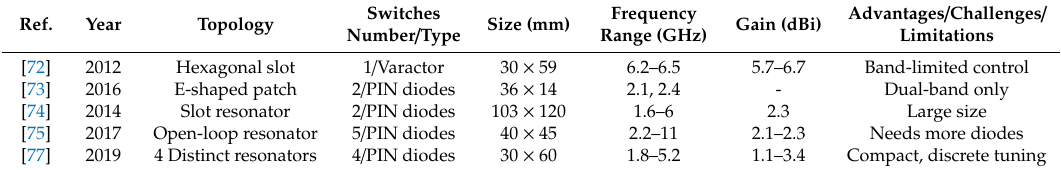
Table 4. Comparison between some reconfigurable filter–antenna designs.